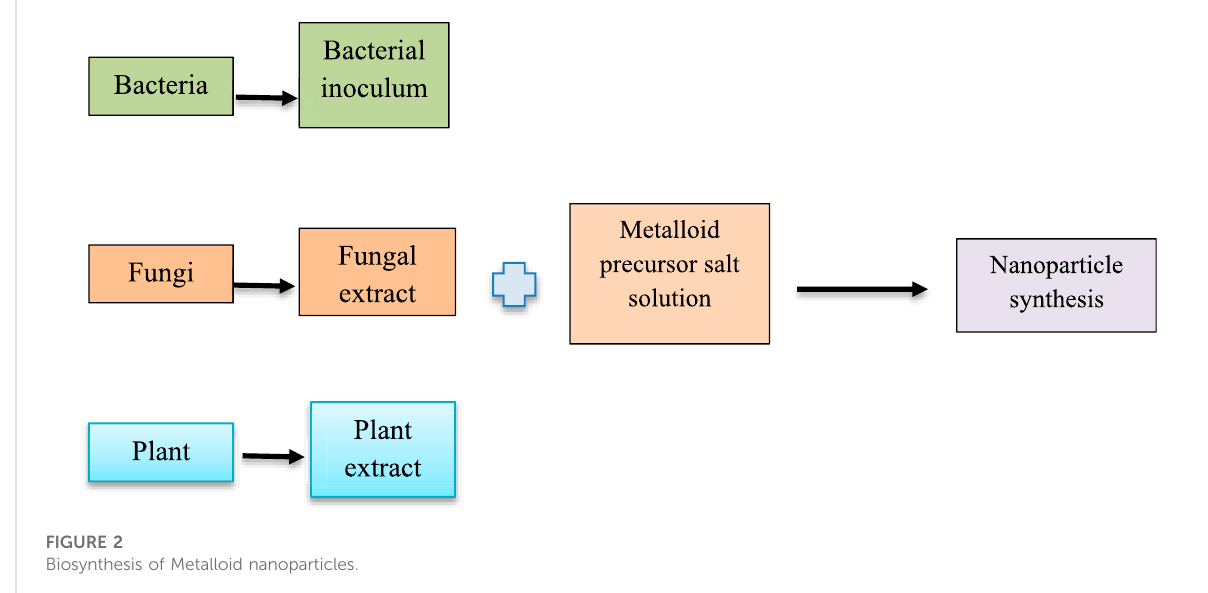
FIGURE 2 Biosynthesis of Metalloid nanoparticles.